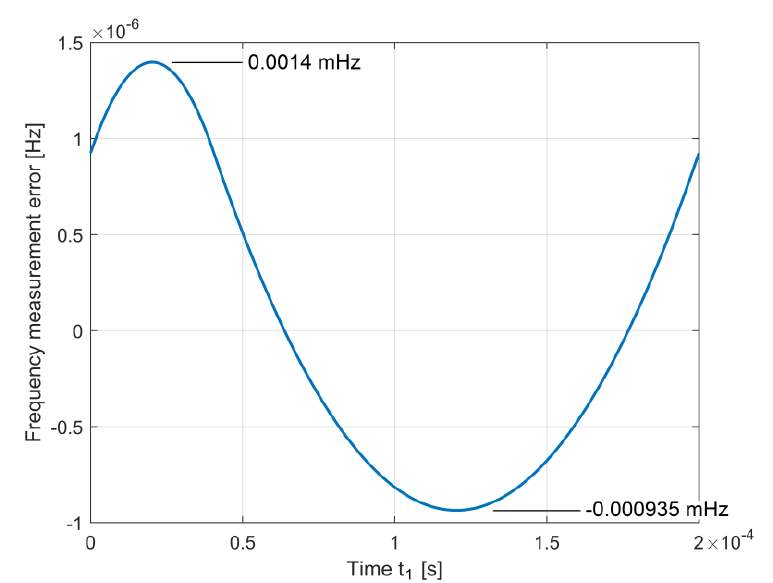
Figure 16. The evolution of the frequency measurement error ε f (for a simulated harmonic signal with combination frequency f c = 17.383 Hz) versus the evolution of the first sampling time ( t 1 = 0 ÷ ∆ t , or t 1 = 0 ÷ 200 µ s) involved in the first zero-crossing time ( t zc 1 ) calculus.